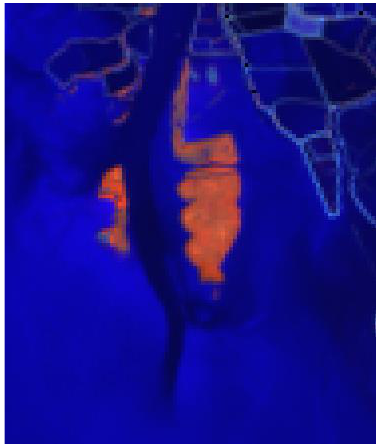
Figure 2 . False Color Composite (NIR- SWIR1-RED)